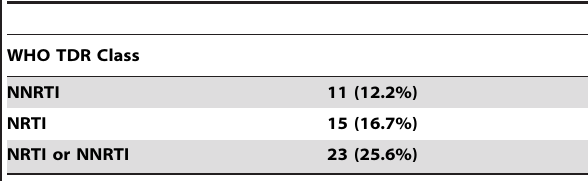
Table 2. Number of Subjects with a WHO TDR by Deep